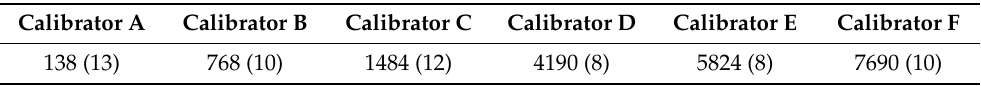
Table 1. Mean counts and CV of kit calibrators over time, measured on the LDx/NS2400 platform; n = 12; mean (CV).